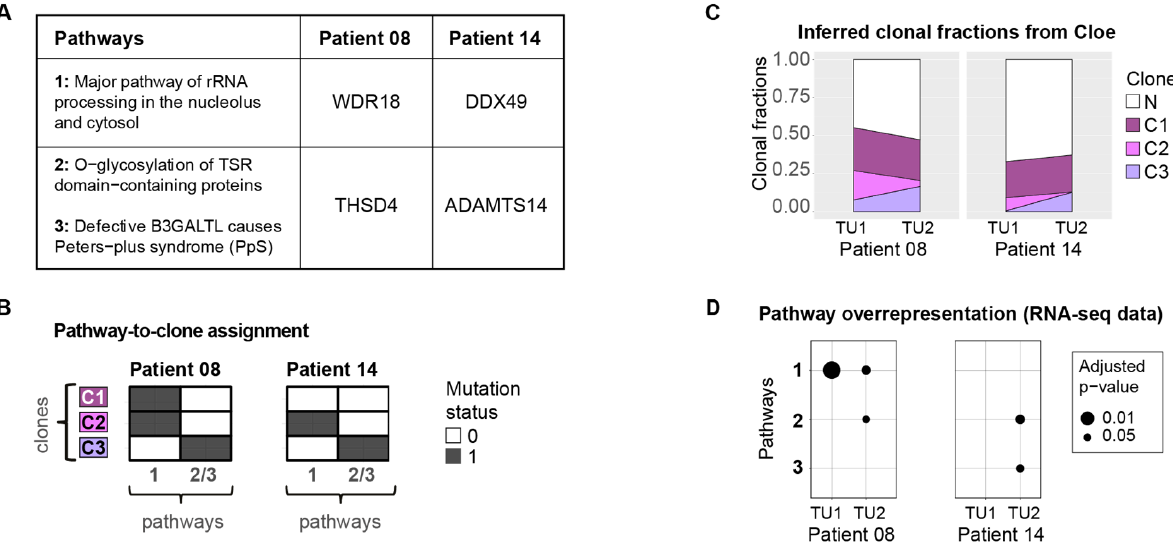
Figure 4. The two most striking clonally exclusive pathway pairs from the clonal exclusivity test when performed on the pathway level of the WES data set from 16 ccRCC patients. The pathway pairs are affected in patients 8 and 14 and in each patient, a different subset of genes is mutated. Hence, this clonal exclusivity pattern is only detectable on the pathway level. ( A ) The table displays the genes that are mutated in these pathways. ( B ) The heatmaps illustrate in which clones the genes in these pathways are mutated. ( C ) The proportion of cells from the clones in each of the two samples from the two patients. The label “N” represents the fraction of normal cells in the biopsy. ( D ) The data set also includes RNA-seq data from each sample. Among the differentially expressed genes in each sample, the pathways are significantly overrepresented in some of the samples.